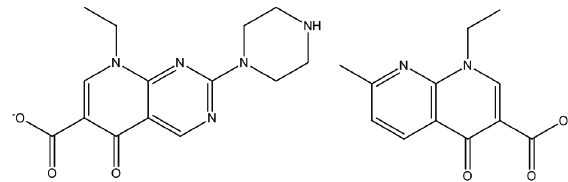
Figure 1: Chemical structures of anions of pipemidic acid (left ) and nalidixic acid